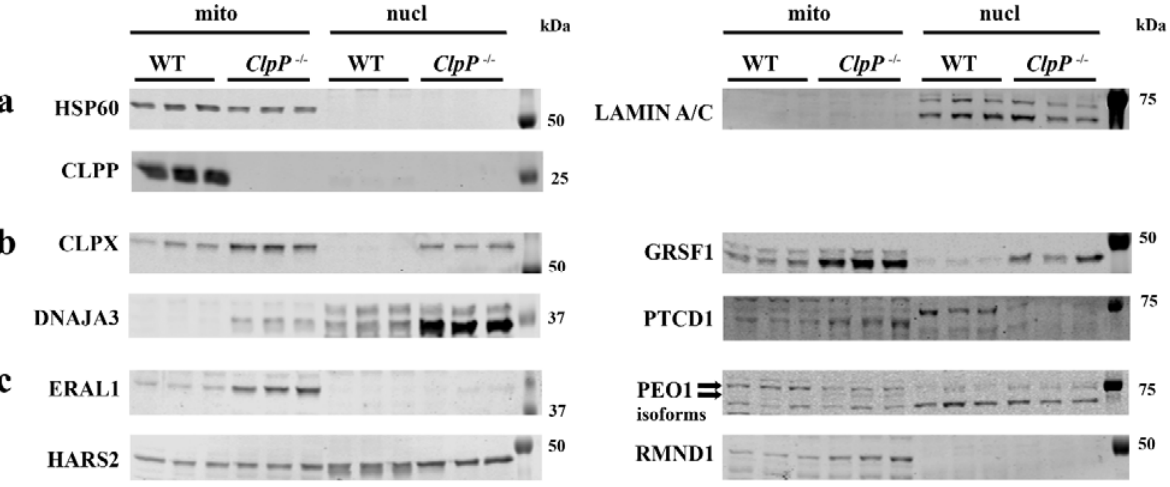
Figure 5. Excess of mitochondrial proteins can trigger redistribution to nuclear fraction. Testis P21 was fractionated with differential detergents and protein extracts were analyzed by quantitative immunoblots, normally blocked with BSA. ( a ) Fractionation purity was controlled by mitochondrial marker HSP60 and nuclear membrane markers LAMIN-A/C, sample genotype was controlled by assessment of CLPP presence. ( b ) Evident relocalization from mitochondria to nuclei was again observed for excess CLPX and its interactome component GRSF1, as well as the mature small isoform TID1S of DNAJA3. In contrast, the accumulation occurred purely in mitochondria for PTCD1. ( c ) Immunoblots confirmed CLPP to modulate the abundance of several PRLTS proteins. ERAL1 was accumulated in the mitochondrial fraction, and a faint band was apparent in mutant nuclear fractions. In contrast, PEO1 detection with a commercial rabbit polyclonal antibody directed against the C-terminal half showed a decrease in full-length 77 kDa Twinkle band with the parallel accumulation of 66 kDa Twinky band (arrows on the left side). A nuclear redistribution was not detected for any PEO1 isoform. HARS2 immunoreactivity of appropriate molecular weight was observed in the nucleus even for WT samples, with strong accumulation for CLPP-null samples. The assessment of RMND1 also suggested mitochondrial accumulation, but no presence in the